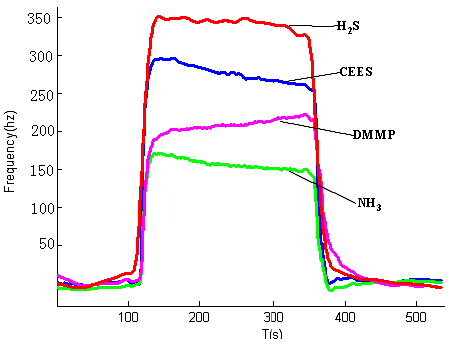
Figure 6. ( a ) Sketch map of the wireless communication module used in this study; ( b ) Position located by GPS in practical experiments.